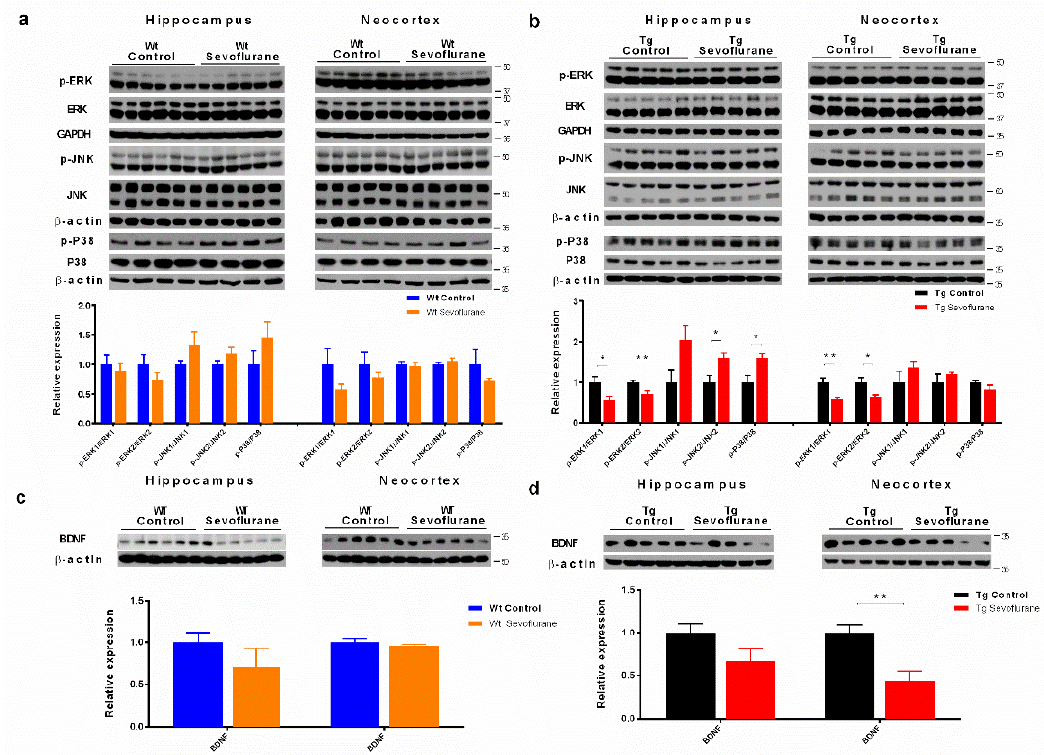
Figure 4. Sevoflurane differentially regulated MAPK signaling activities and BDNF in wild-type and 3 × Tg mice. Sevoflurane differentially regulated various MAP kinase phosphorylation in the hippocampus and the neocortex of ( a ) wild-type and ( b ) 3 × Tg mice. BDNF was not affected in wild-type mice ( c ) but reduced in 3 × Tg mice ( d ). Bar graphs below show the quantification of Western blot. All data correspond to the mean ± SEM ( n = 5–6) and represent the band densities that were normalized with the endogenous loading control. * p < 0.05, ** p < 0.01 in comparison to the control. Values were analyzed using the unpaired t -test.